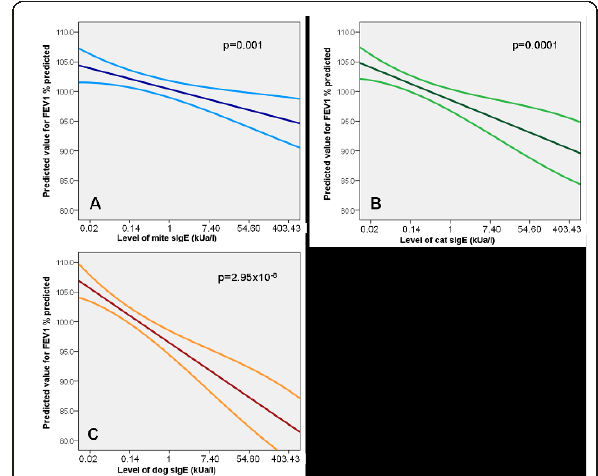
Figure 1 Predicted value for FEV 1 % predicted in relation to sensitization to mite (A), cat (B) and dog (C) - sIgE level (kU A /l), derived from the linear regression analysis (regression line with 95% CI) .